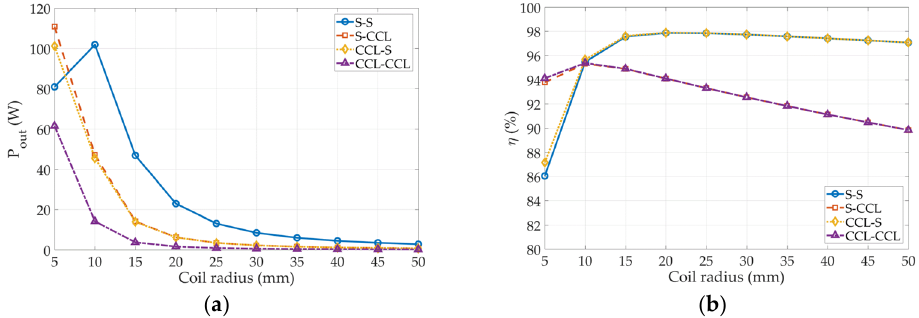
Figure 11. ( a ) Transmitting power and ( b ) power transfer efficiency variation with coil radius for WPT system topologies.